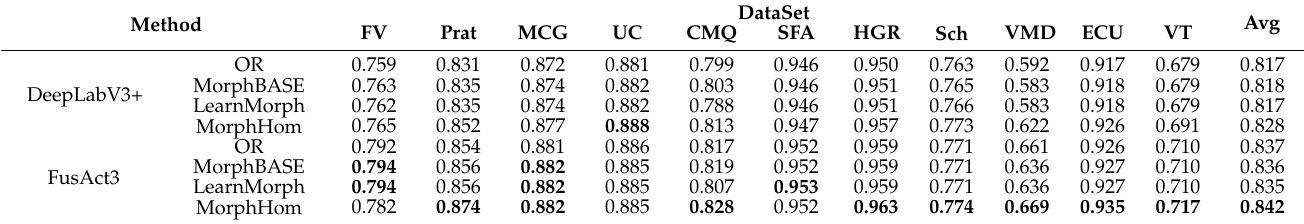
Table 5. F1-measure of the tested methods (N.B. bold-face indicates superior results).